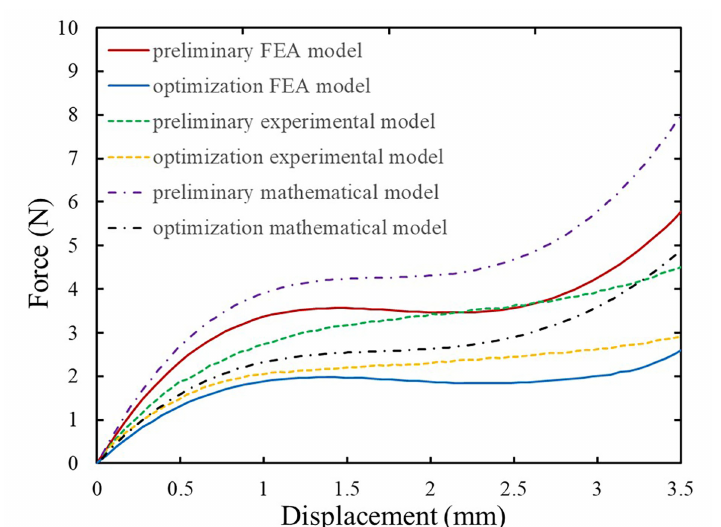
Figure 12. The experimental results, mathematical results and FEA results in the preliminary model and the optimized model are